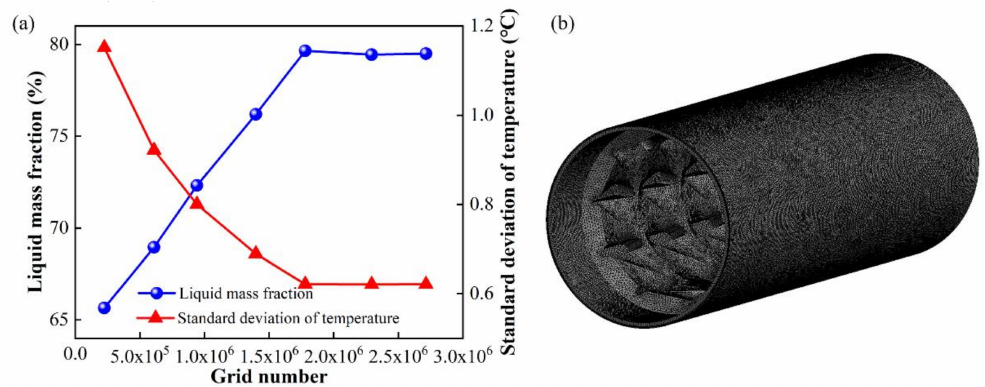
Figure 3. Grid independent test for data of liquid mass fraction and standard deviation of temperature ( a ), and the discrete model with about 2,100,000 cells ( b